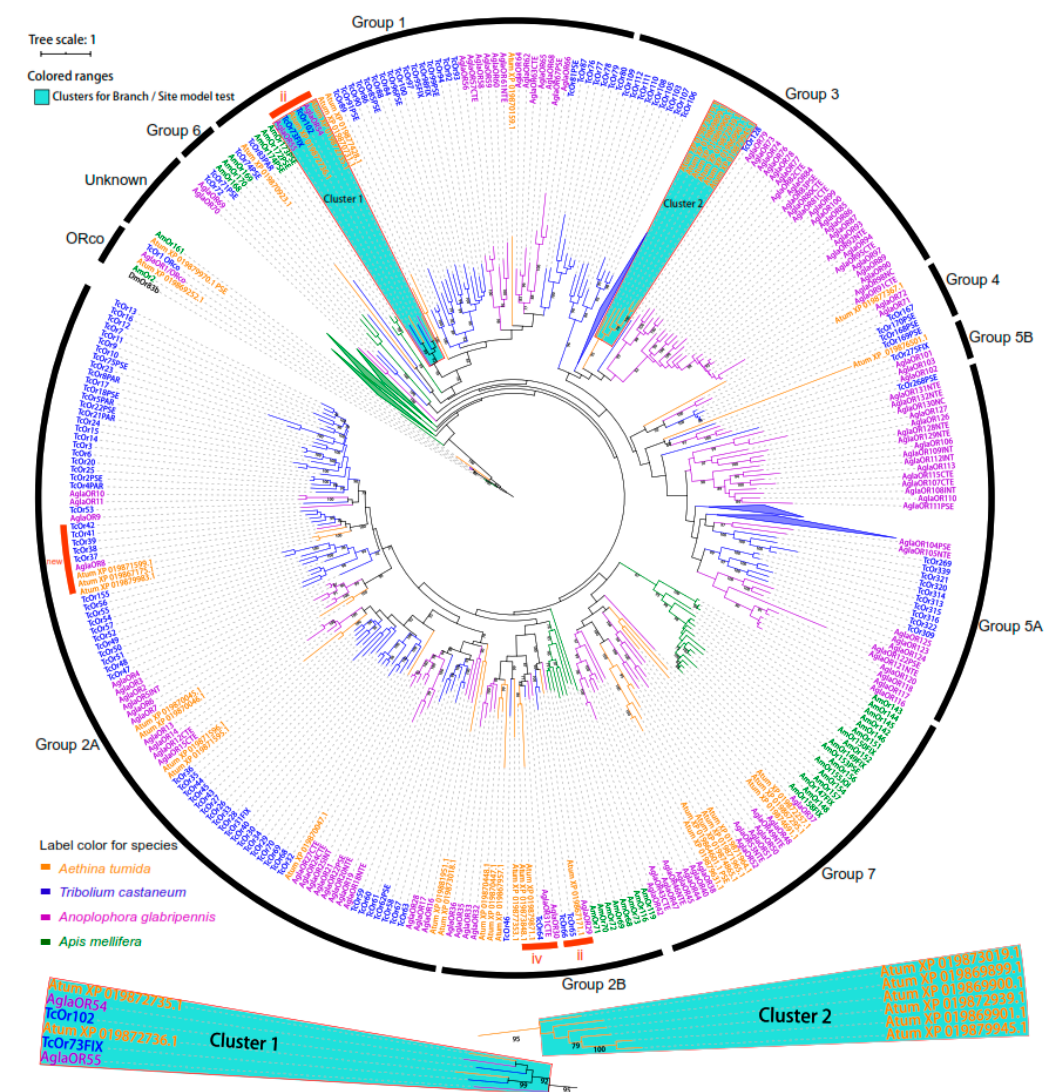
Figure 2. Dendrogram of the odorant receptor (OR) gene family of five species. The sequence similarity tree was reconstructed using maximum likelihood methods with RaxMLv8.0 using amino acid sequences of OR genes ( > 200 aa). The OR coreceptor (Orco) orthologue was used to root the tree [28]. ORs of Aethina tumida , Tribolium castaneum , Anoplophora glabripennis , and Apis mellifera are shown in orange, blue, violet, and green, respectively. The numbers above branches indicate bootstrap support value bigger than 75 (RaxML; n = 1000). The tree was divided into nine major groups (Group 1, 2A, 2B, 3, 4, 5A, 5B, 6, and 7) in black arcs [30], plus one unknown group and the group of Orco including members of Orco from other species, namely, TcOr1 / ORco, Agla OR1 / ORco, Atum XP_019869252.1, AmOr2, and DmOr83b. Names of odorant receptors for other species were kept as originally described [28,43]. Conserved lineages of ORs were shown in red arcs and kept the names of ‘ii’ and ‘iv’ given when they were previously identified, and a ‘new’ conserved OR lineage was discovered in this study. Several clades that have lineage-specific expansions were collapsed (see triangles in the tree). Branches marked with Cluster 1 and Cluster 2 were tested for positive selection with tests of branch models and site models in PAML [44]. The scale bar displayed the branch lengths of the tree. The dendrogram was visualized in iTOL [45] and edited in Adobe Illustrator ® CS6 (Adobe Inc., San Jose, CA, USA).